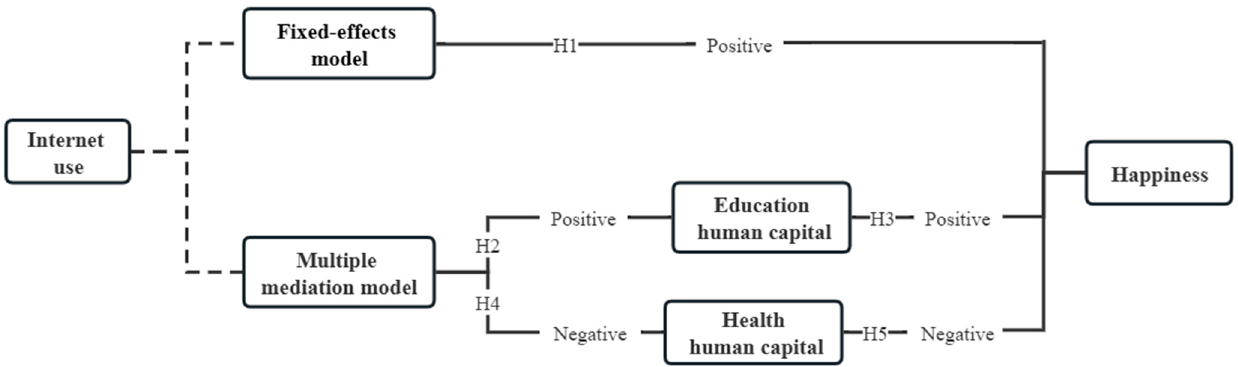
Figure 2. Test results of the theoretical and mechanism framework of the relationship between Internet use and rural residents’ happiness.